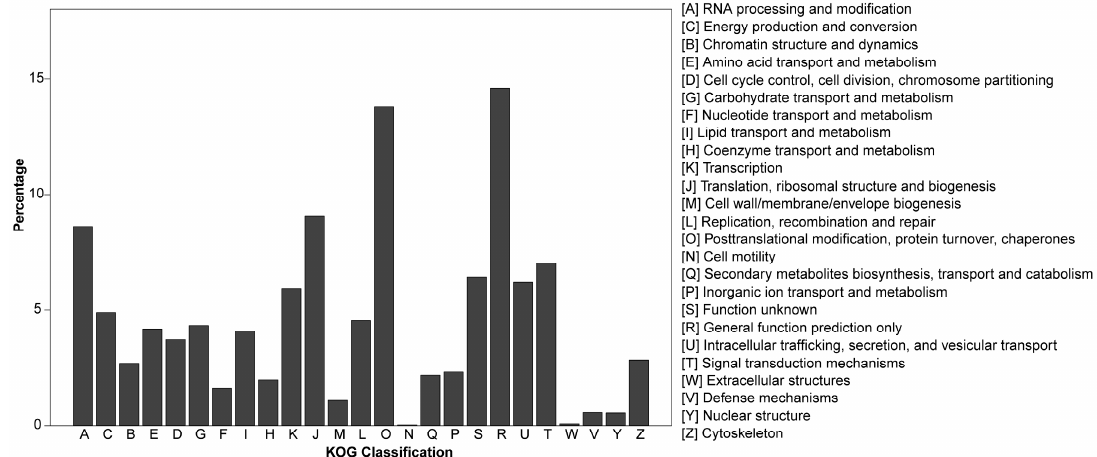
Figure 2. KOG functional classification of P. bungeana unigenes.